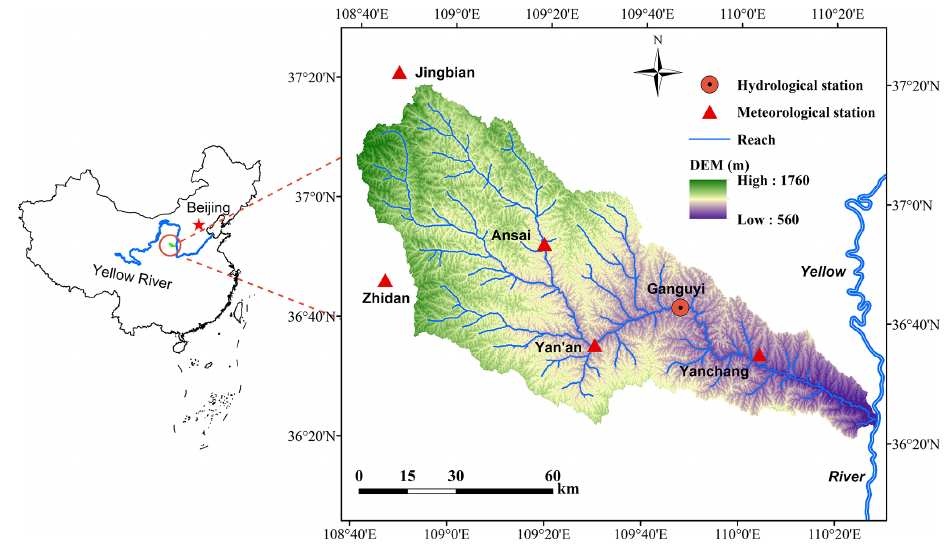
Figure 1. Map of the Yanhe Basin showing the elevation and the locations of the meteorological and hydrological stations.